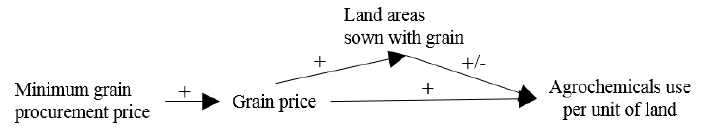
Figure 1. Theoretical